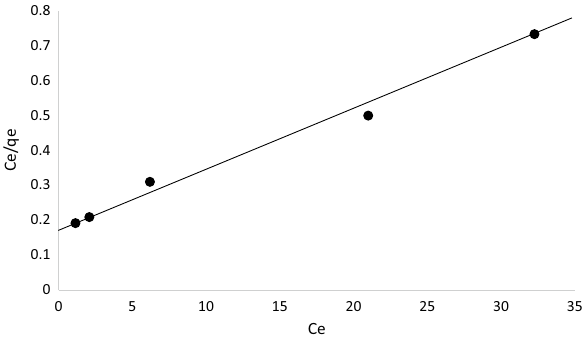
Fig. 11 Temkin adsorption isothermal plot for the adsorption of Rh-B on AgNPs